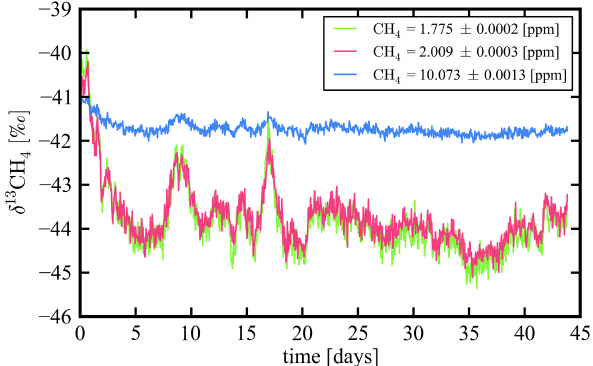
Figure 8. Measurements of the drift correction parameters χ(t i ) (bottom panel) and α 0 (t i ) (top panel), measured from the HI and LO bottles as described in the text. At 2ppm CH 4 , the parameter α 0 (t i ) dominates the drift.